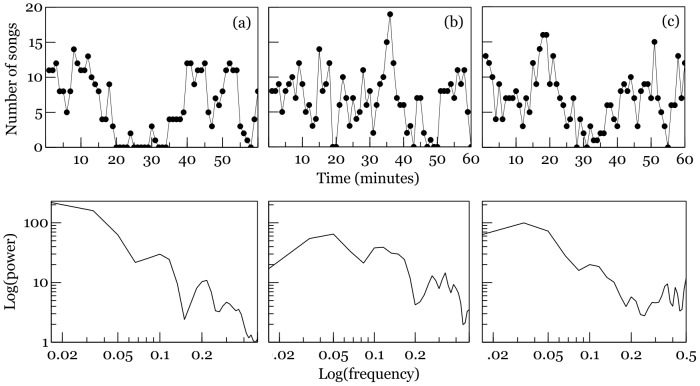
Representative time series of numbers of songs (upper panel) and their power spectra: (a) random walk, (b) mean-reversive AR1, (c) AR2.